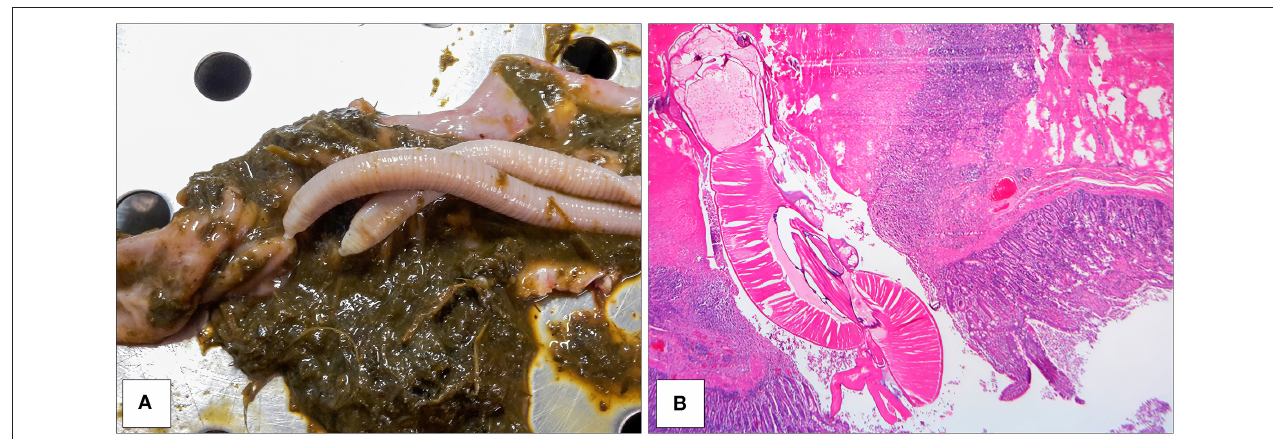
FIGURE 4 | Specimens of M. hirudinaceus attached in the intestinal mucosa (A) . Intestine showing dense compressed necrotic tissue adjacent to the apical portion of helminth. The tissue surrounding this area contained numerous lymphocytes and monocytes. Eroded villi and necrotic epithelial cells around the trunk of the worm (EE 2.5X) (B)